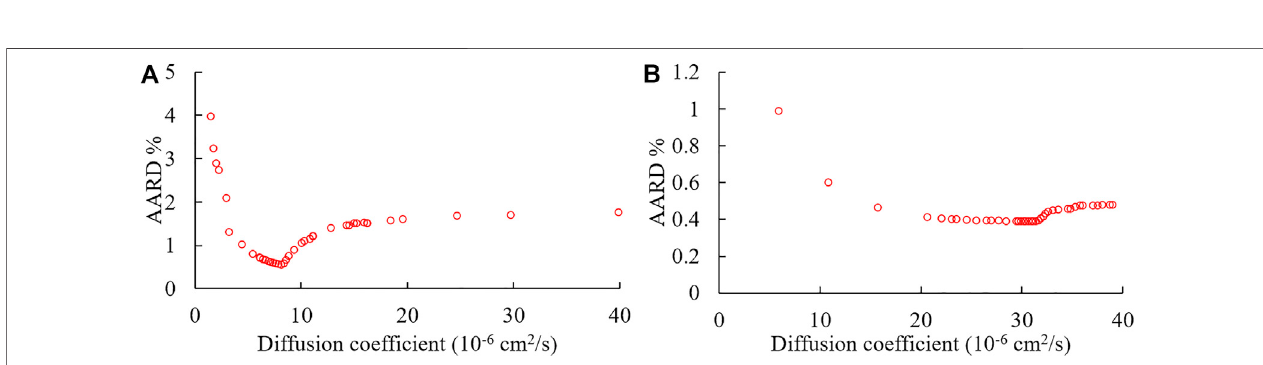
FIGURE 5 | Estimation of diffusion coef fi cients of Test 1 (A) and Test 2 (B) .